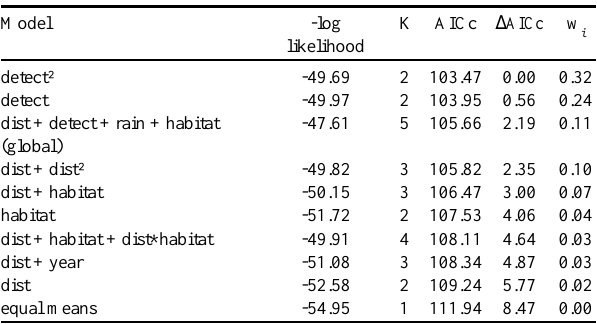
Table 2 . Model selection results for the probability of raptor nest occupancy in the Lac de Gras study area during 2000 to 2010. Shown are number of model parameters (K), Akaike’s Information Criterion score (AICc) and difference from top model ( D AICc), and relative model weight (w i